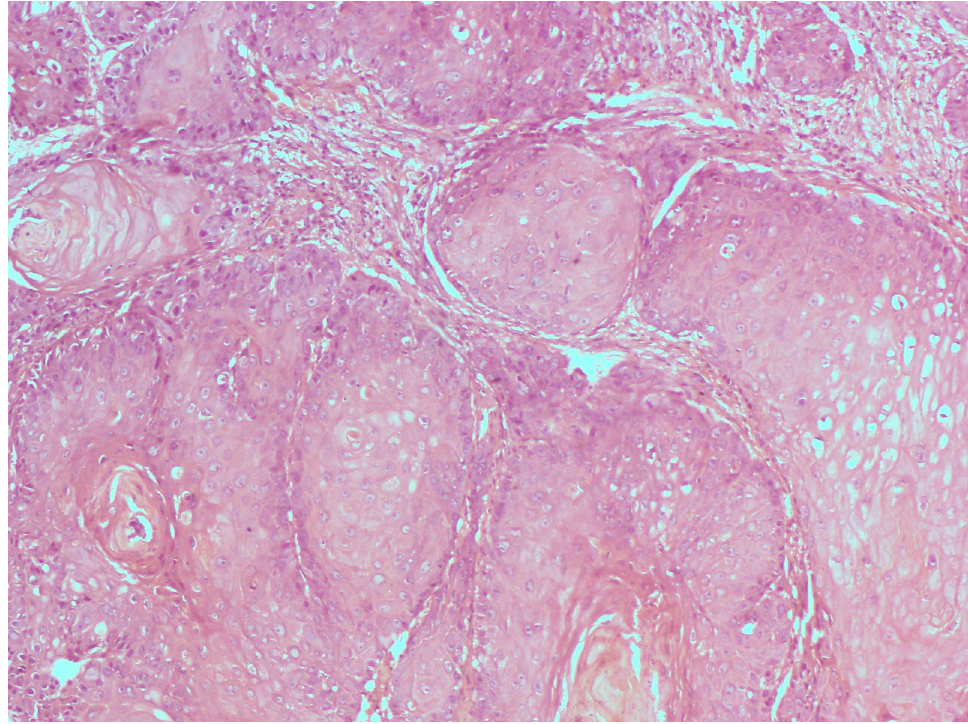
Fig 2. Photomicrograph showing well differentiated large cell keratinizing squamous cell carcinoma (Haematoxylin and eosin stains,